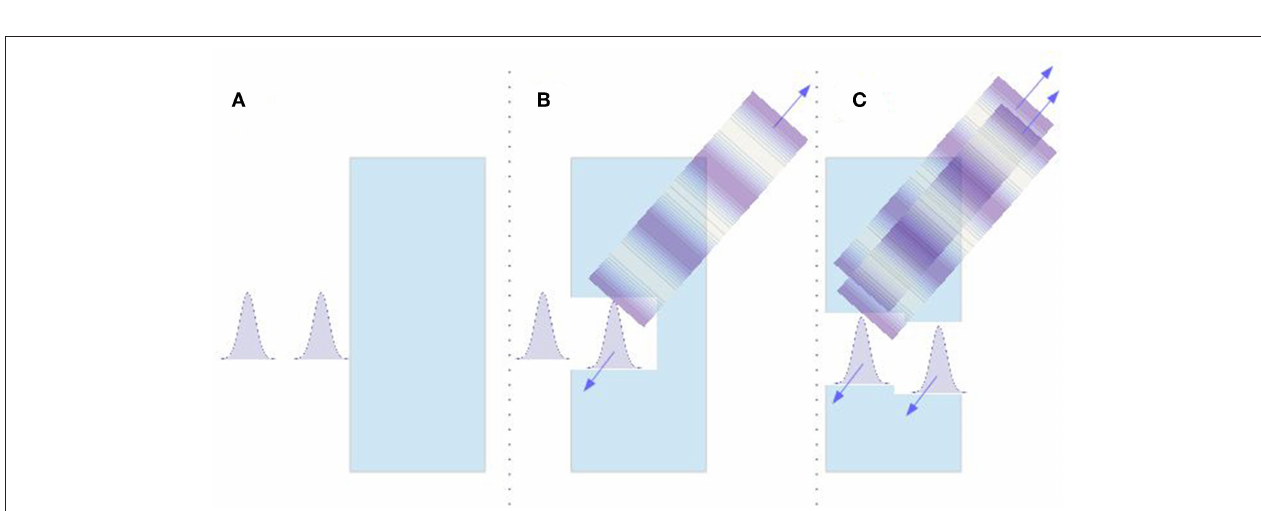
FIGURE 2 | Standard configuration analyzed in the literature. (A) When the external field is absent, the atom remains in a long-lived, not radiating state. (B) At t the electric field is turned on, simultaneously at all points occupied by the wave-packet. The atomic state becomes short-lived and decays by spontaneous emission. The act of emission changes atomic center-of-mass momentum via a recoil, creating an entangled atom-photon state. Tracing out the atomic degrees of freedom one obtains a mixed state of a single photon, with incoherent contributions from both atomic peaks. Spectrum of the emitted radiation is modified only by Doppler shifts, statistically distributed in accordance with the probability density of atomic center-of-mass momenta.